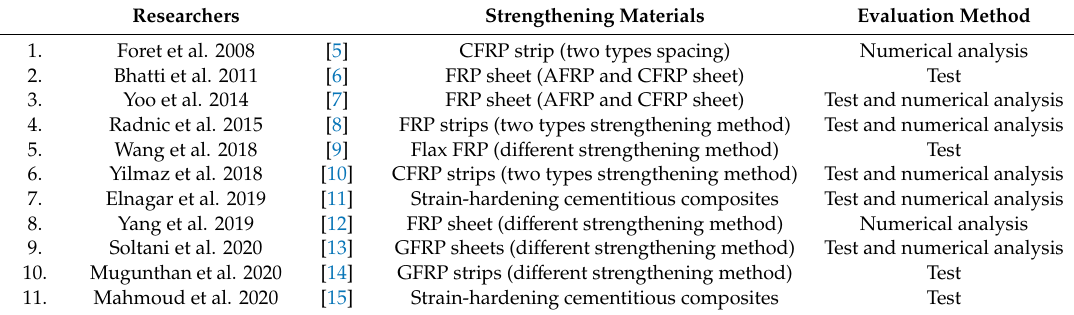
Table 1. Recent research on reinforced concrete (RC slabs strengthened by di ff erent